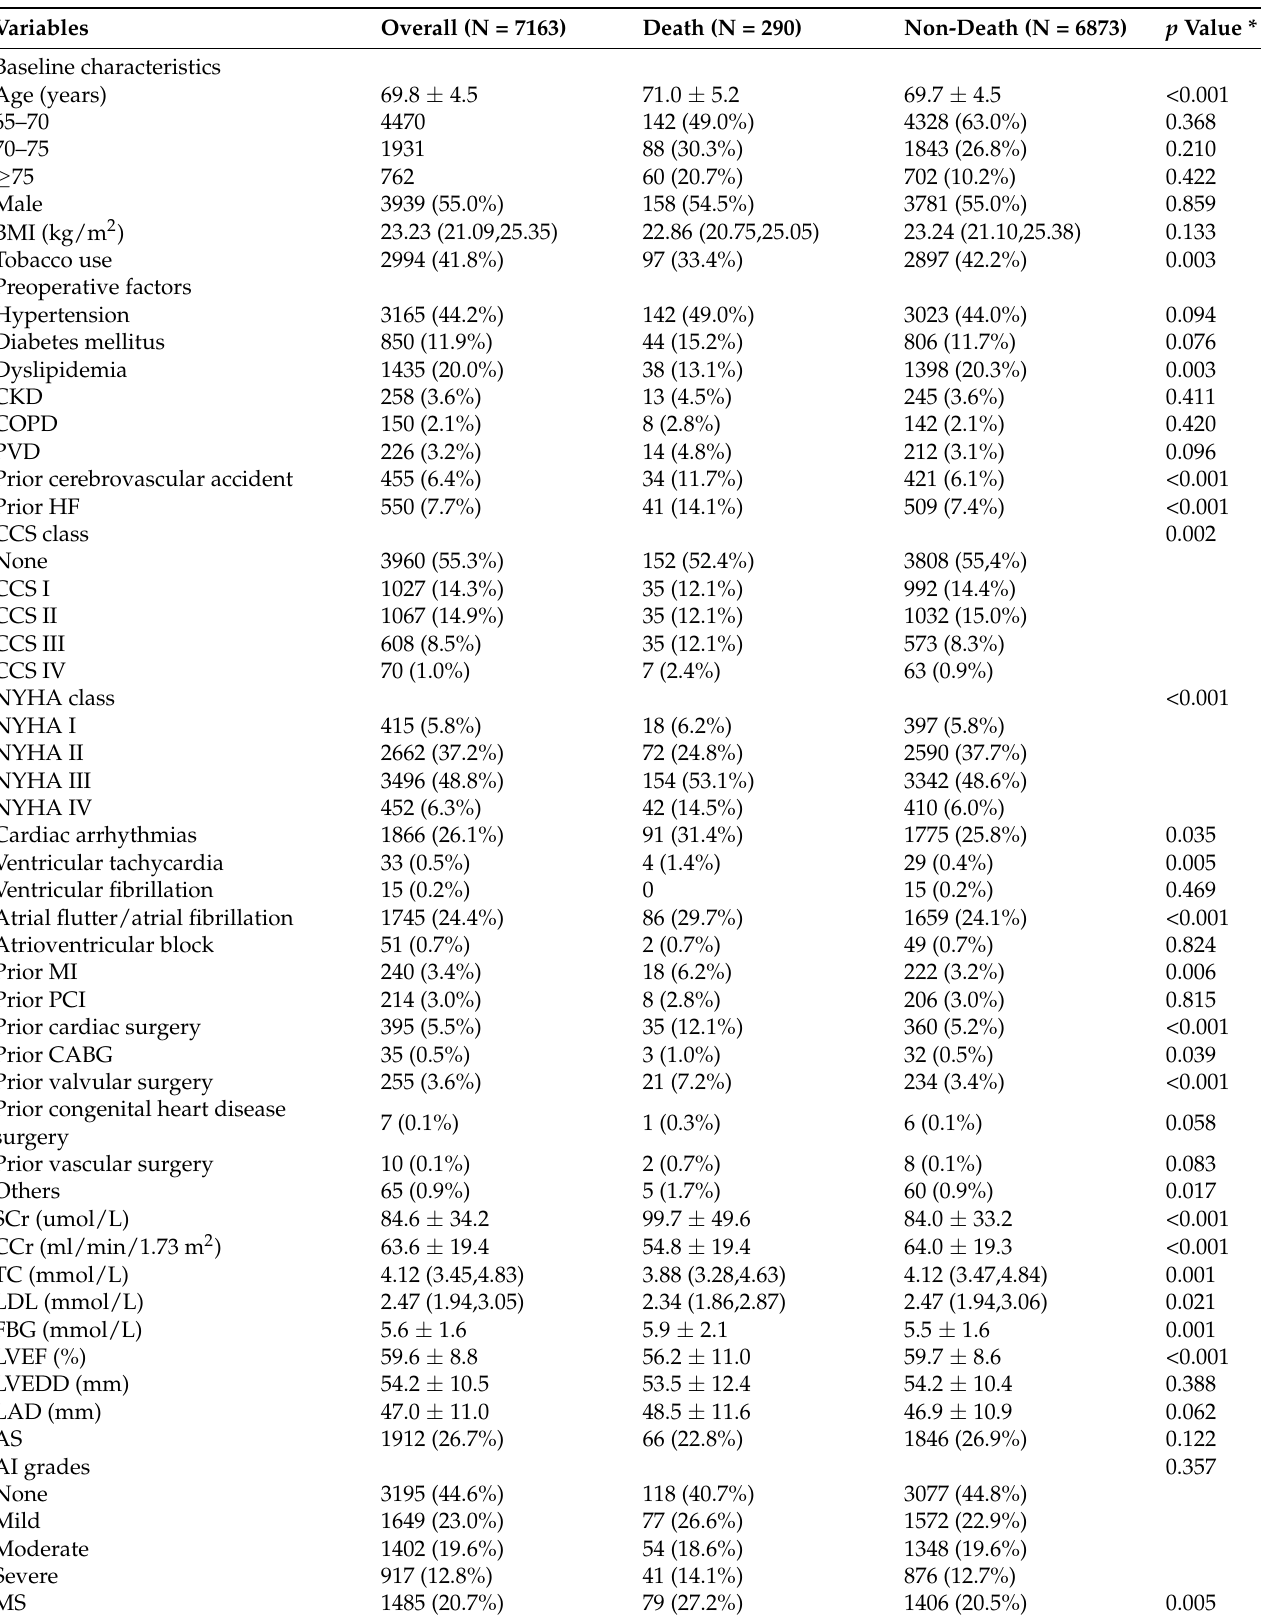
Table 2. Patient demographics and clinical